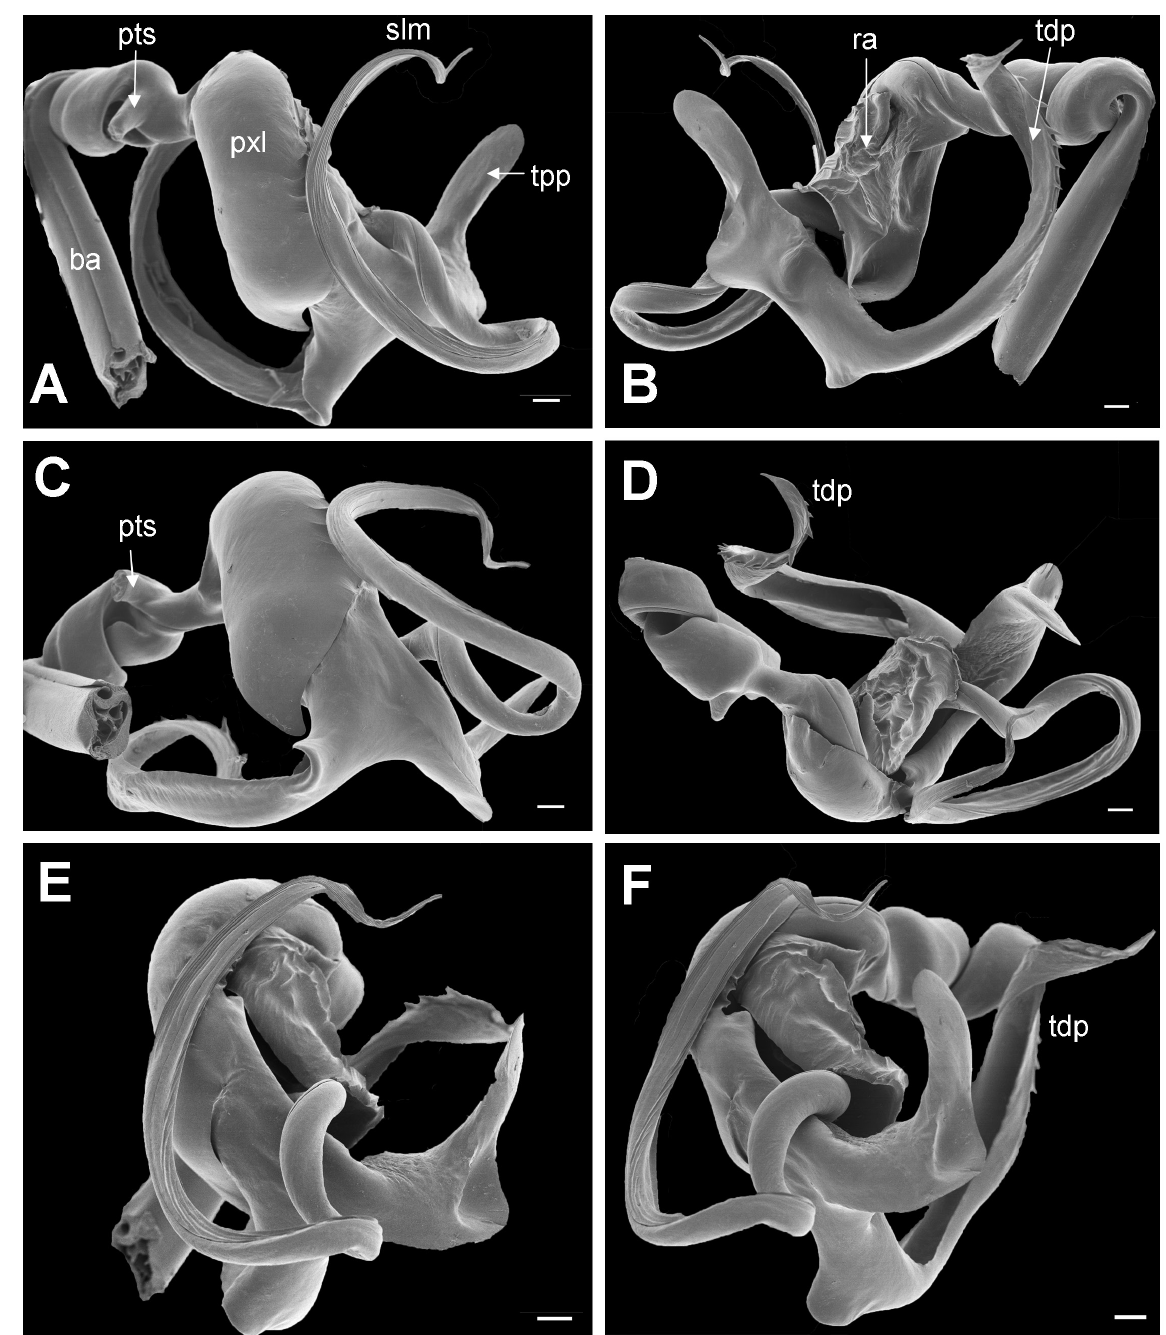
Fig. 4. Prionopetalum asperginis sp. nov., paratype from Kihansi, “forest site”, right gonopod telopodite. A . Anterior and slightly mesal view. B . Posterior view. C . Basal view. D . Apical view. E . Apical-mesal view. F . Mesal and slightly posterior view. Abbreviations: ba = basomere; pts = post-torsal spine (broken); pxl = proximal lobe of telomere; ra = rough area of telomere; slm = solenomere; tdp = distal process of telomere; tpp = proximal process of telomere. Scale bars = 0.1